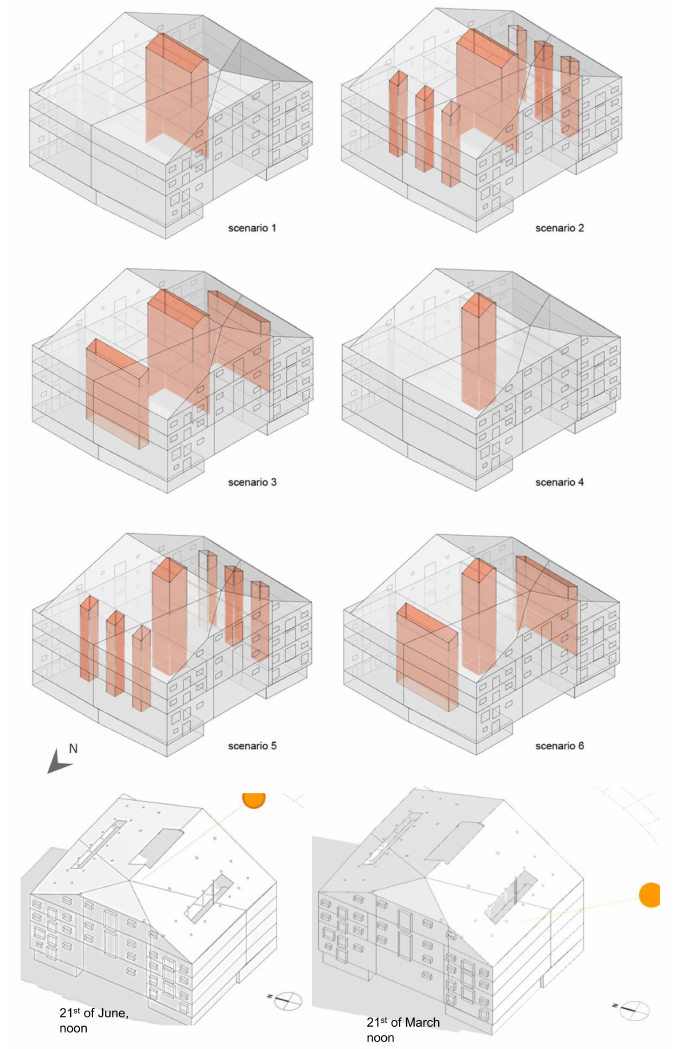
Figure 7. Schematic view of the six configurations that were defined for corelighting of the building through skylights and light atria. The position of the sun hitting the building is also